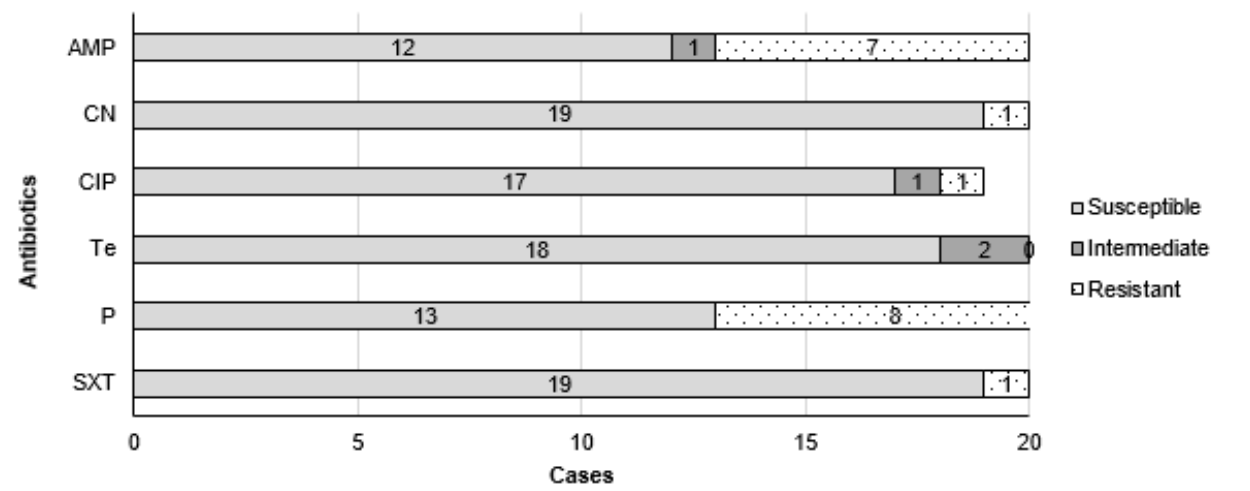
Figure 3. Antibiotic resistance of microorganism species isolated from honey bee pollen samples: AMP—ampicillin; CN—gentamicin; CIP—ciprofloxacin; Te—tetracycline; P—penicillin G; SXT— trimethoprim–sulfamethoxazole.